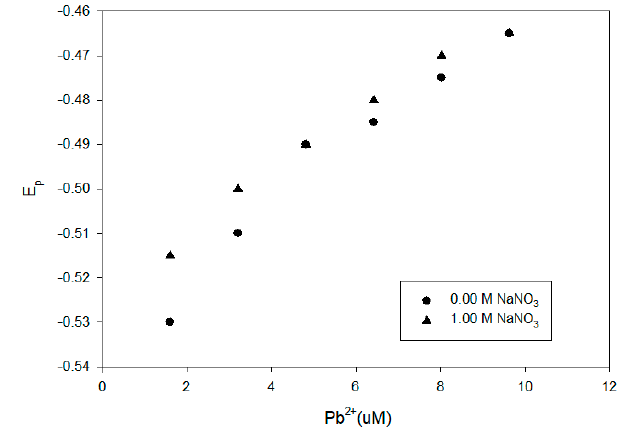
Figure 8. Comparison of DPP results for Pb 2+ at pH 8 in the presense of 100 mg/L of the various humic acids.